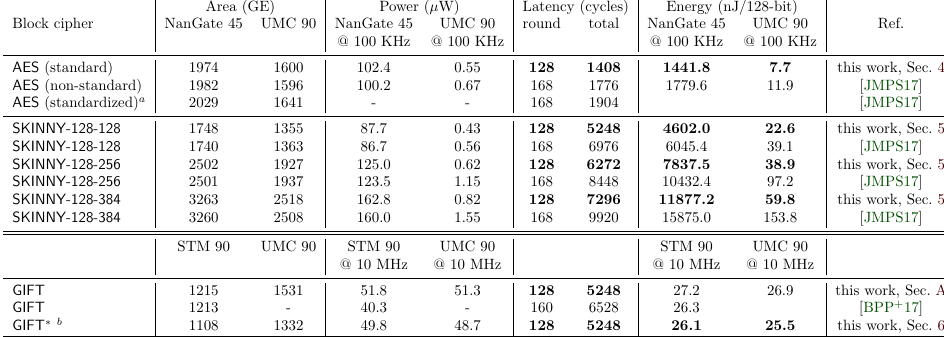
Table 2: The comparison of our work with the state of the art in terms of latency, area, power and energy. The measurements respect to the use of the same library and clock frequency, NanGate 45 nm and UMC 90 nm for AES , SKINNY and STM 90 nm for GIFT ∗ . For fair comparison, all power figures are measured at frequencies reported in the original papers [JMPS17, BPP + 17]. a It has been estimated in [MPL + 11] that converting a non- standardized to a standardized circuit requires an additional 20 MUXes. The area figures in this row is obtained by adding the area of 20 MUXes to the figures in the previous row. b GIFT ∗ refers to the slightly modified version of GIFT used in SUNDAE-GIFT [BBP + 19].